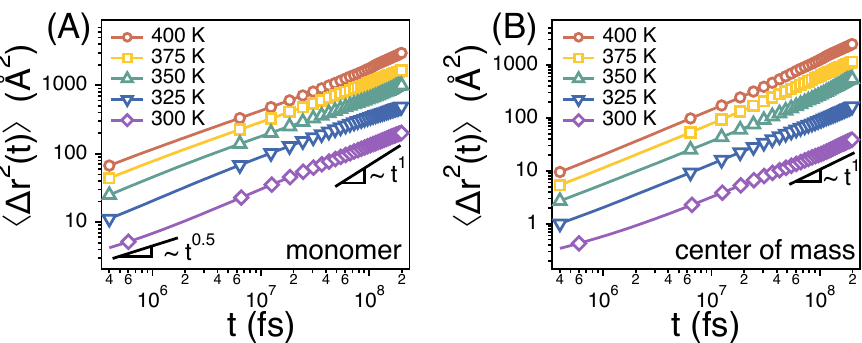
Figure 3. Simulation results for the mean-square displacements ( (cid:104) ∆ r 2 ( t ) (cid:105) ) of ( A ) monomers and ( B ) the centers of mass of PEO chains at different temperatures. Solid lines are guides with exponents of 1 and 1/2. The statistical errors are smaller than the markers.